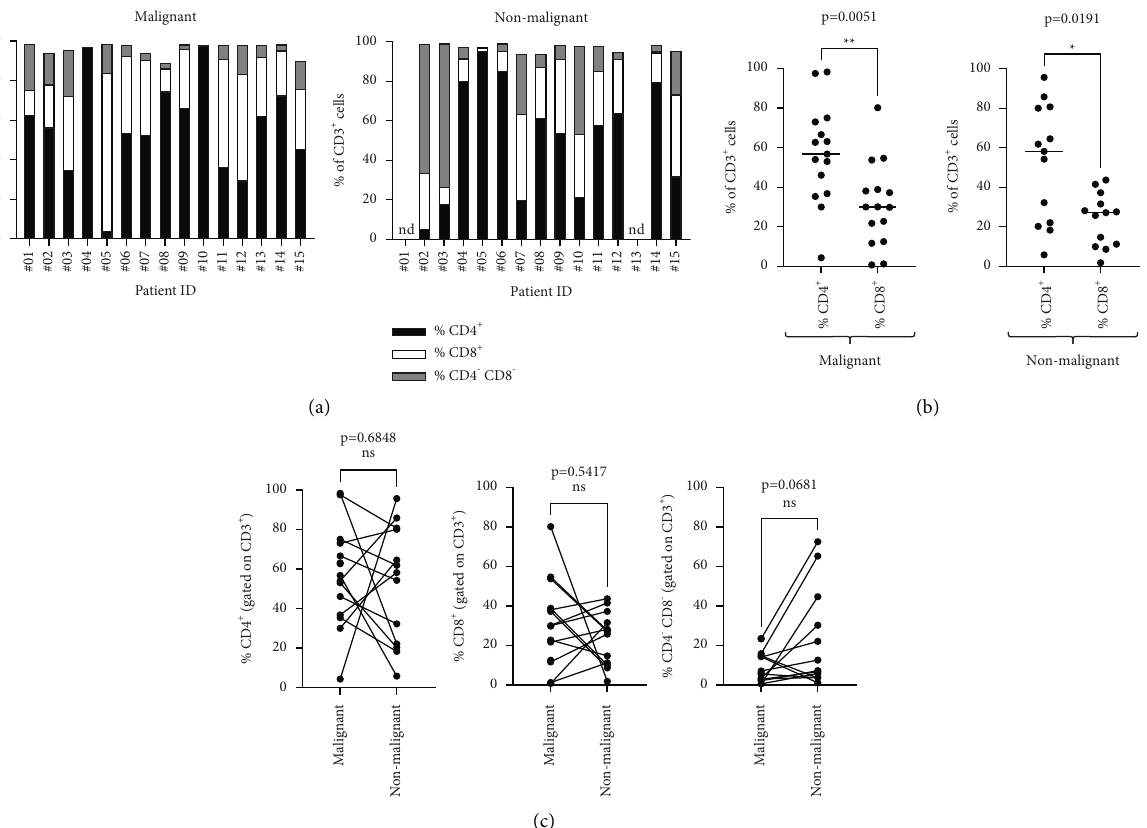
Figure 2: A prominent population of CD4 + T cells are found in TILs from prostate tissues. (a) The proportion of CD4 + , CD8 + , and CD4 − CD8 − cells in the CD3 + population is shown for the TIL culture expanded from each tissue specimen. nd, not done. (b) The proportion of CD4 + Tcells was compared to CD8 + Tcells in TIL cultures from malignant and nonmalignant tissues (Mann-Whitney, two-tailed). (c) The proportions of CD4 + Tcells, CD8 + Tcells, and CD4 − CD8 − Tcells were compared between malignant tissues and matched nonmalignant tissues (paired t -test,